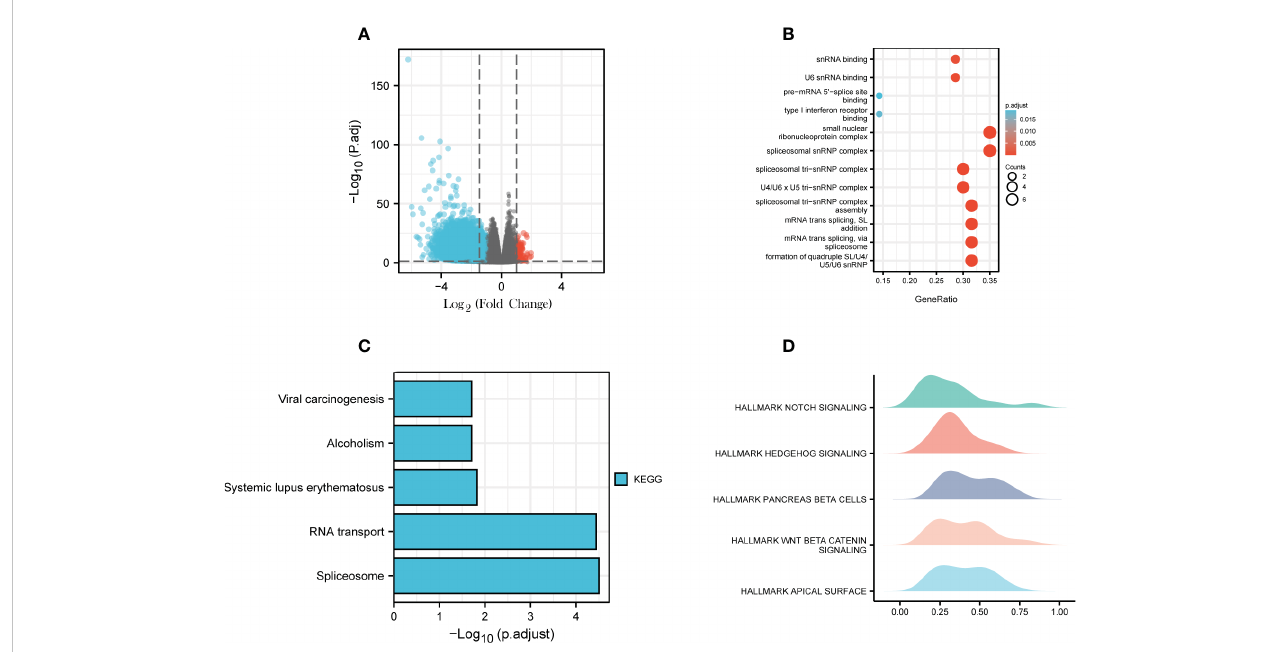
FIGURE 9 Differential Gene Expression Analysis and Enrichment Analysis; (A) USP20 CRC high group/ USP20 CRC low group differential expression genes analysis; volcano plot: red dots indicate signi fi cantly differentially up-regulated genes and blue dots indicate signi fi cantly differentially down-regulated genes; (B) GO enrichment analysis of top 100 downregulated expression genes related to USP20; (C) KEGG enrichment analysis of top 100 downregulated expression genes related to USP20; (D) GSEA analysis of USP20 in